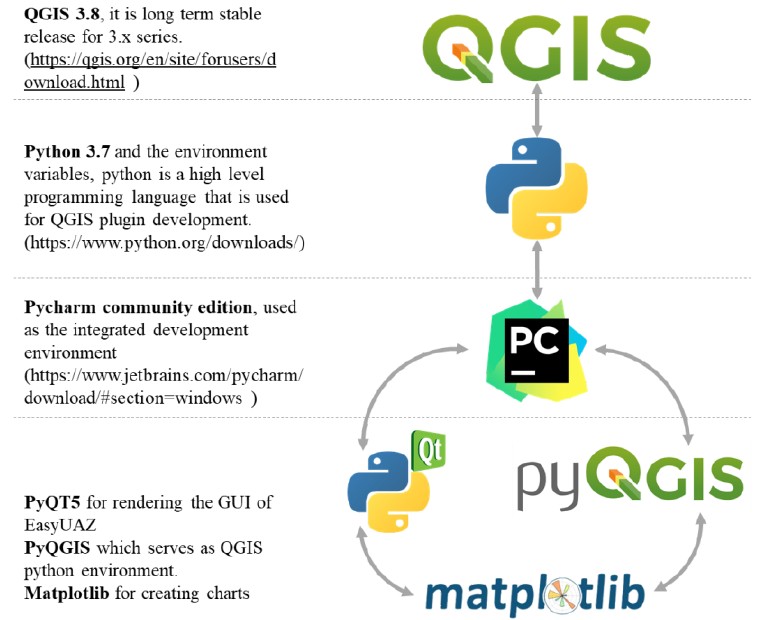
Figure 5. Technology stock behind EasyUAZ.